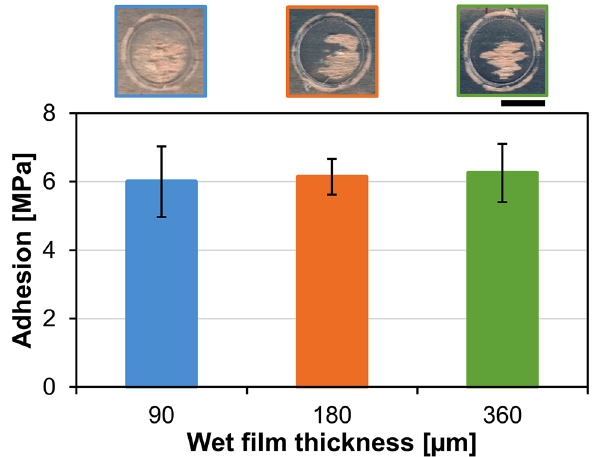
Figure 9. Pull-off adhesion strength of coating films with different wet film thicknesses. The images above the chart show the representative types of failures. The length of the scale bars is 10 mm.